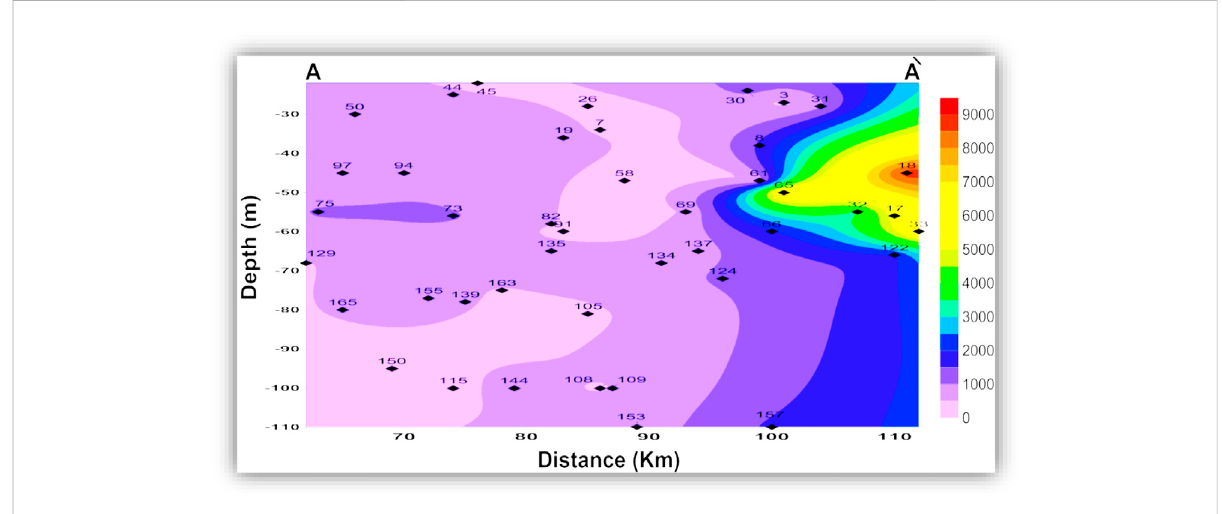
FIGURE 9 Vertical distribution of the groundwater total dissolved solids (TDS, mg/l) along the cross-section AA ’